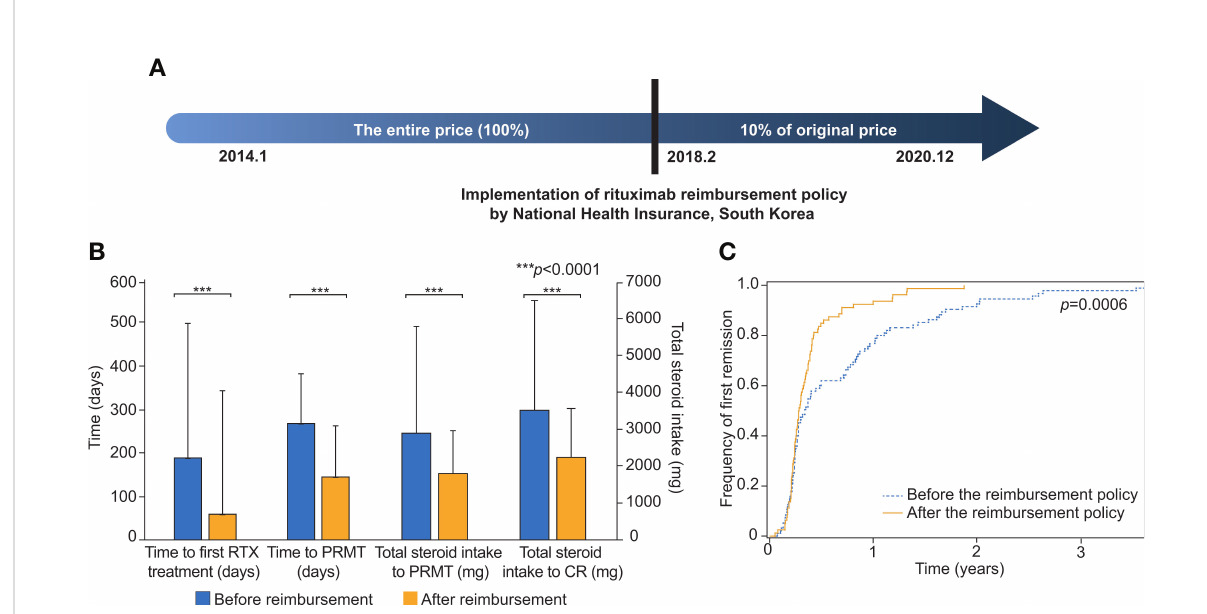
FIGURE 1 Comparisons of clinical outcomes before and after the implementation of the rituximab reimbursement policy. (A) Implementation of the rituximab reimbursement policy by the National Health Insurance of South Korea. Pemphigus patients have paid only 10% of what they used to pay for rituximab treatment since Feb. 2018. (B) The comparisons of time to the fi rst rituximab treatment, time to the fi rst PRMT, total steroid intake to PRMT, and total steroid intake to CR are based on the two groups of patients who were diagnosed before and after the implementation of the rituximab reimbursement policy. (C) Cumulative incidence curves for the fi rst remission in patients diagnosed before and after the rituximab reimbursement policy. The p -value was obtained from Log-rank test. PRMT, Partial remission under minimal therapy; CR, Complete